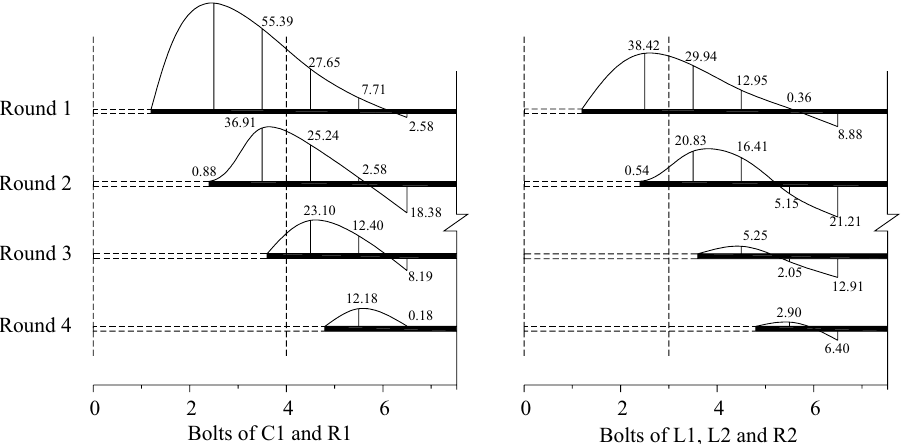
Figure 19. The axial force distribution in the bolts (The unit of axial force: